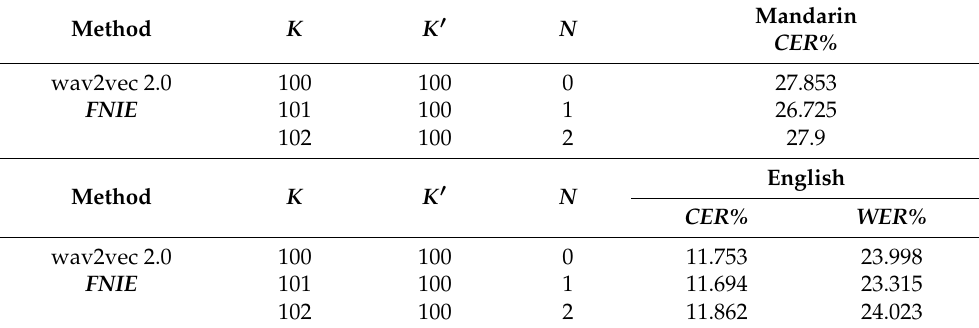
Table 3. Comparison of assimilating different numbers of false negative samples.